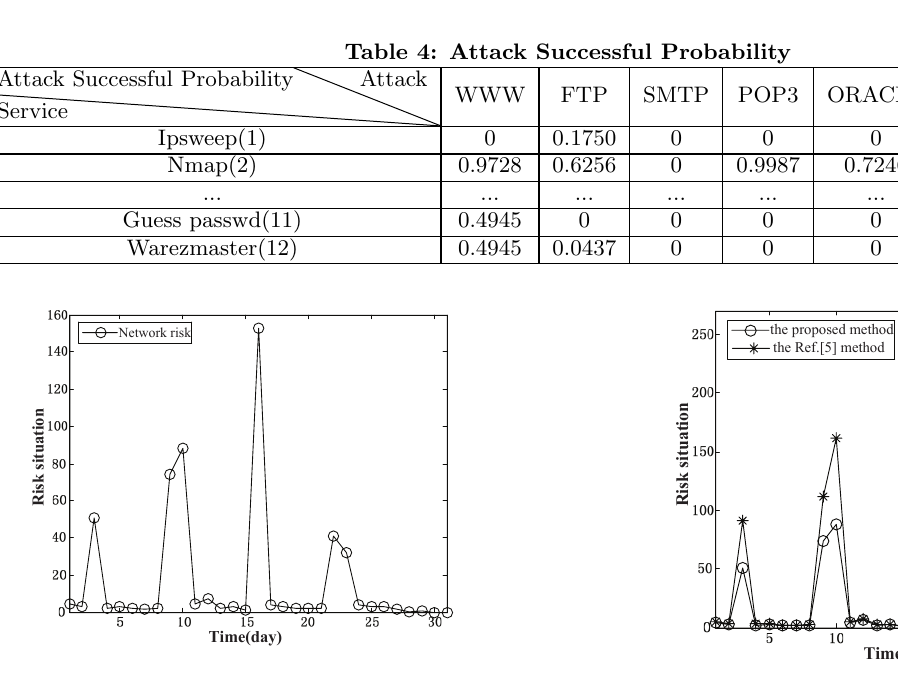
Figure 6: Comparison of Network Risk Assessment with Two Methods legitimate careers, such as on-the-job workers or